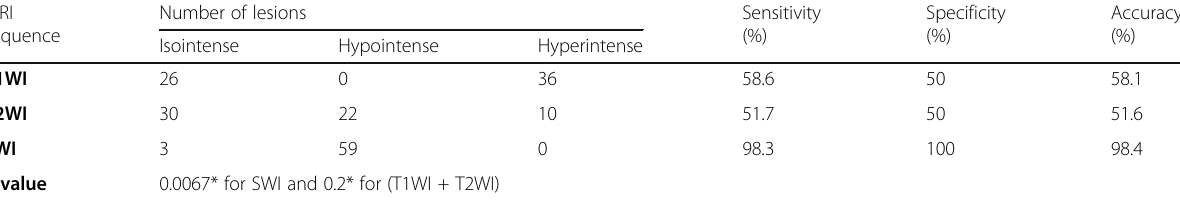
P value *Chi-square test, P value < 0.05 is considered statistically